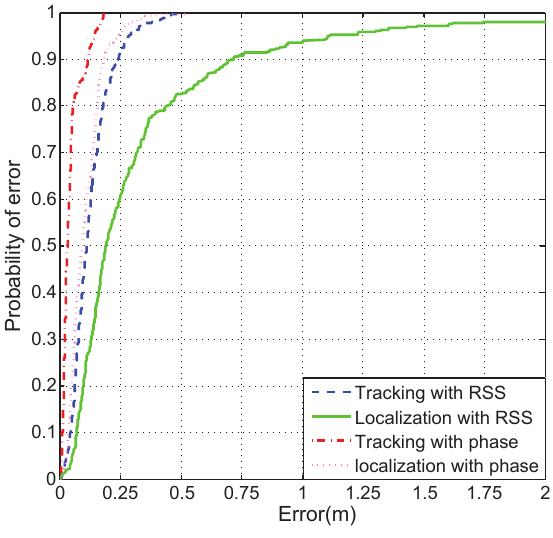
Figure 7. The CDF curves of the circle trajectory tracking and localization error with the RSS and